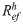
Estimation of Model TMAL in Period 4 (October/2008—September/2012).(a) observed incidence (O) and adjusted i (E), (b) m3/m, (c) Refh (h) and Refm (m), and (d) Ref=Refh×Refm.